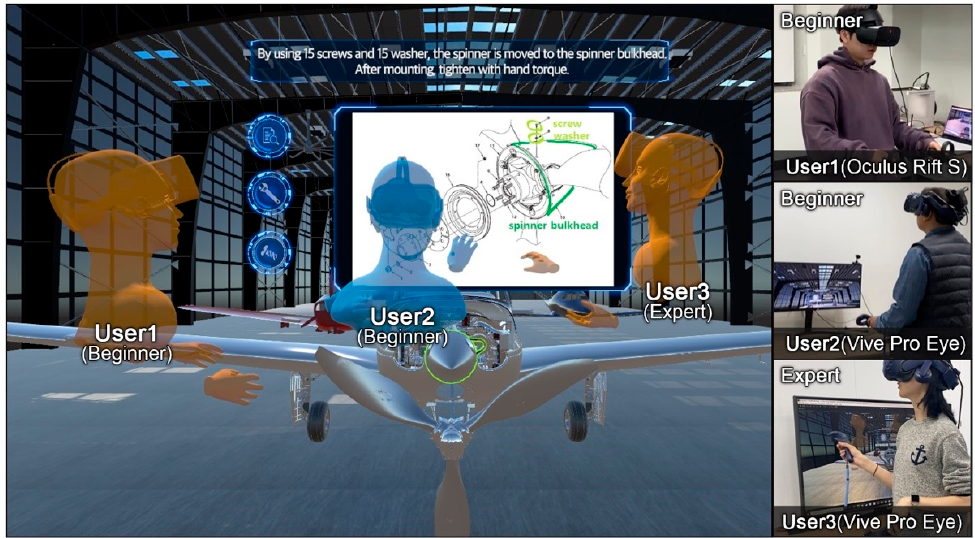
Figure 4. Aircraft maintenance simulation using the proposed system.